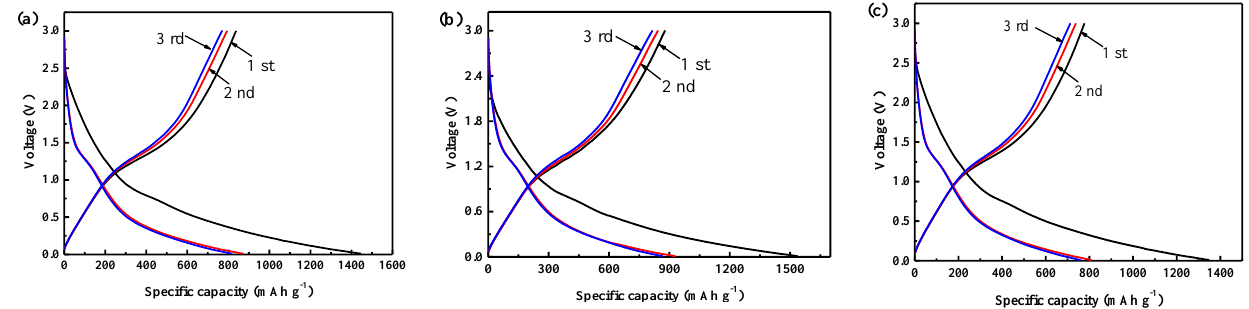
Figure 7. Charge and discharge curves of composite materials at different calcination temperatures: ( a ) MON-QD/NG-500; ( b ) MON-QD/NG-600; ( c ) MON-QD/NG-700.